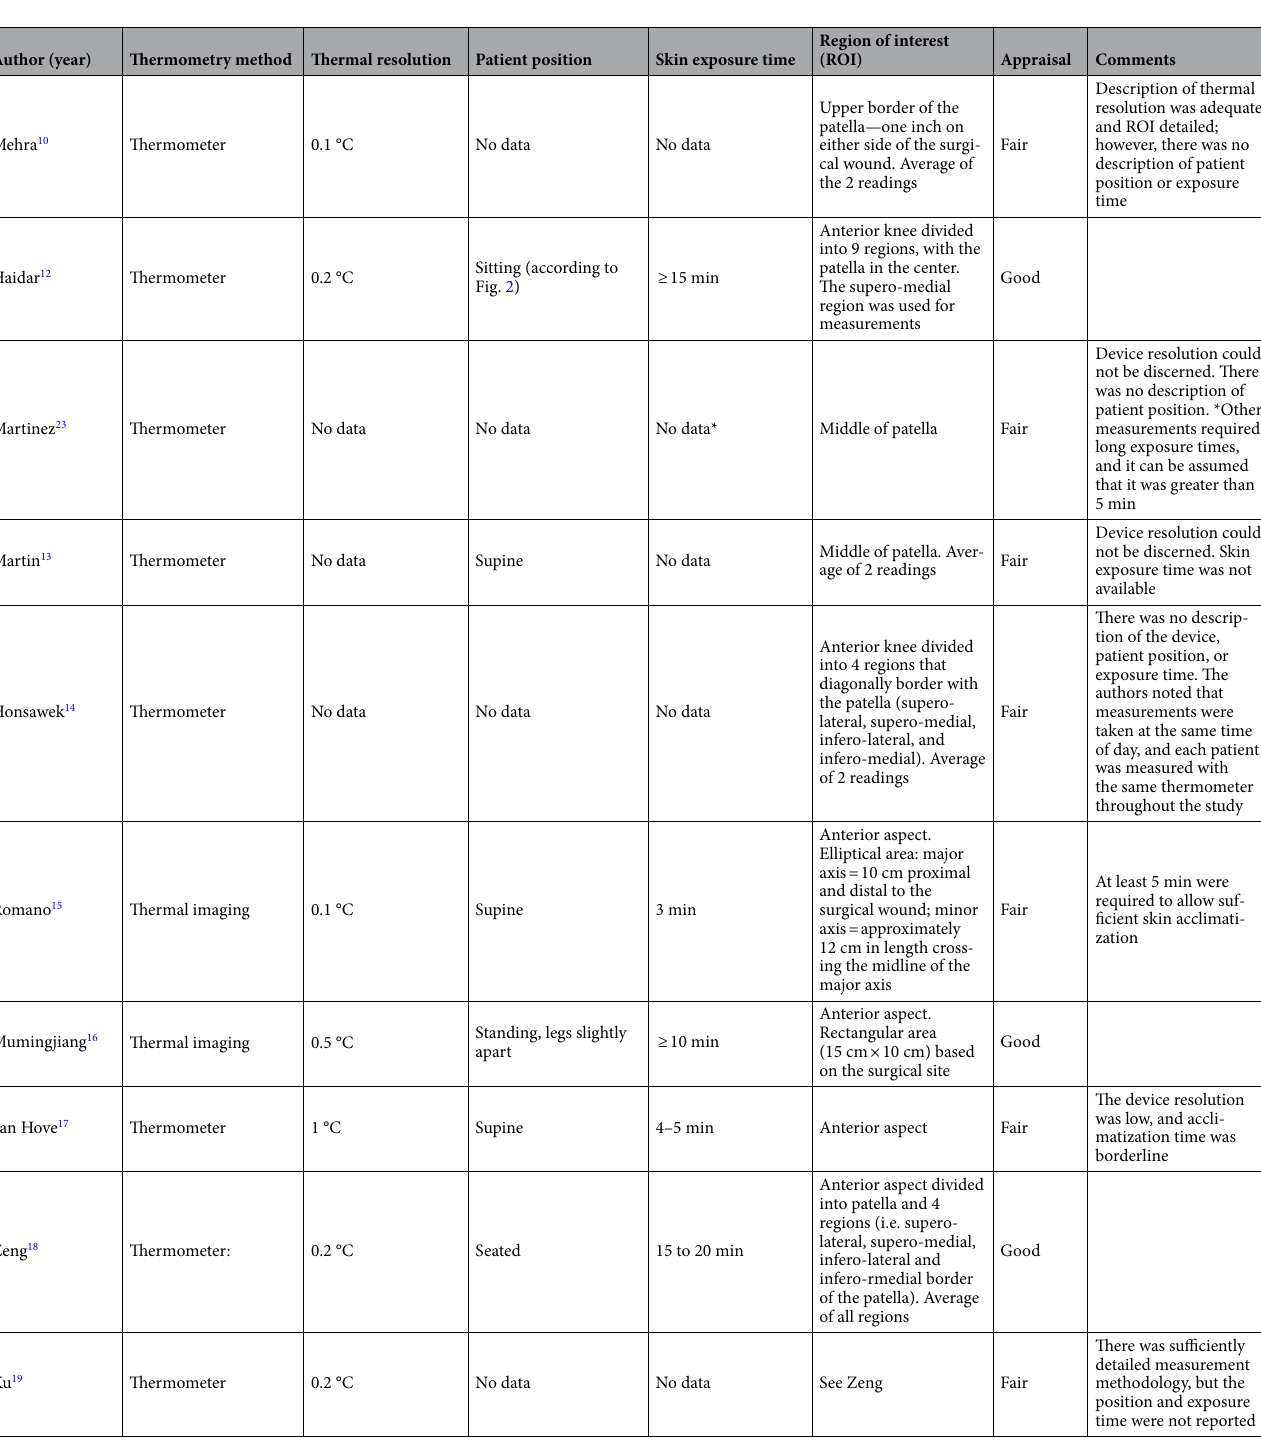
Table 2. Appraisal of Thermal